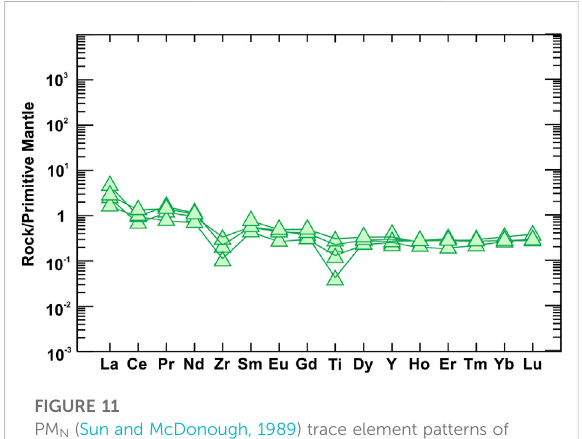
FIGURE 11 PM N (Sun and McDonough, 1989) trace element patterns of Gomati